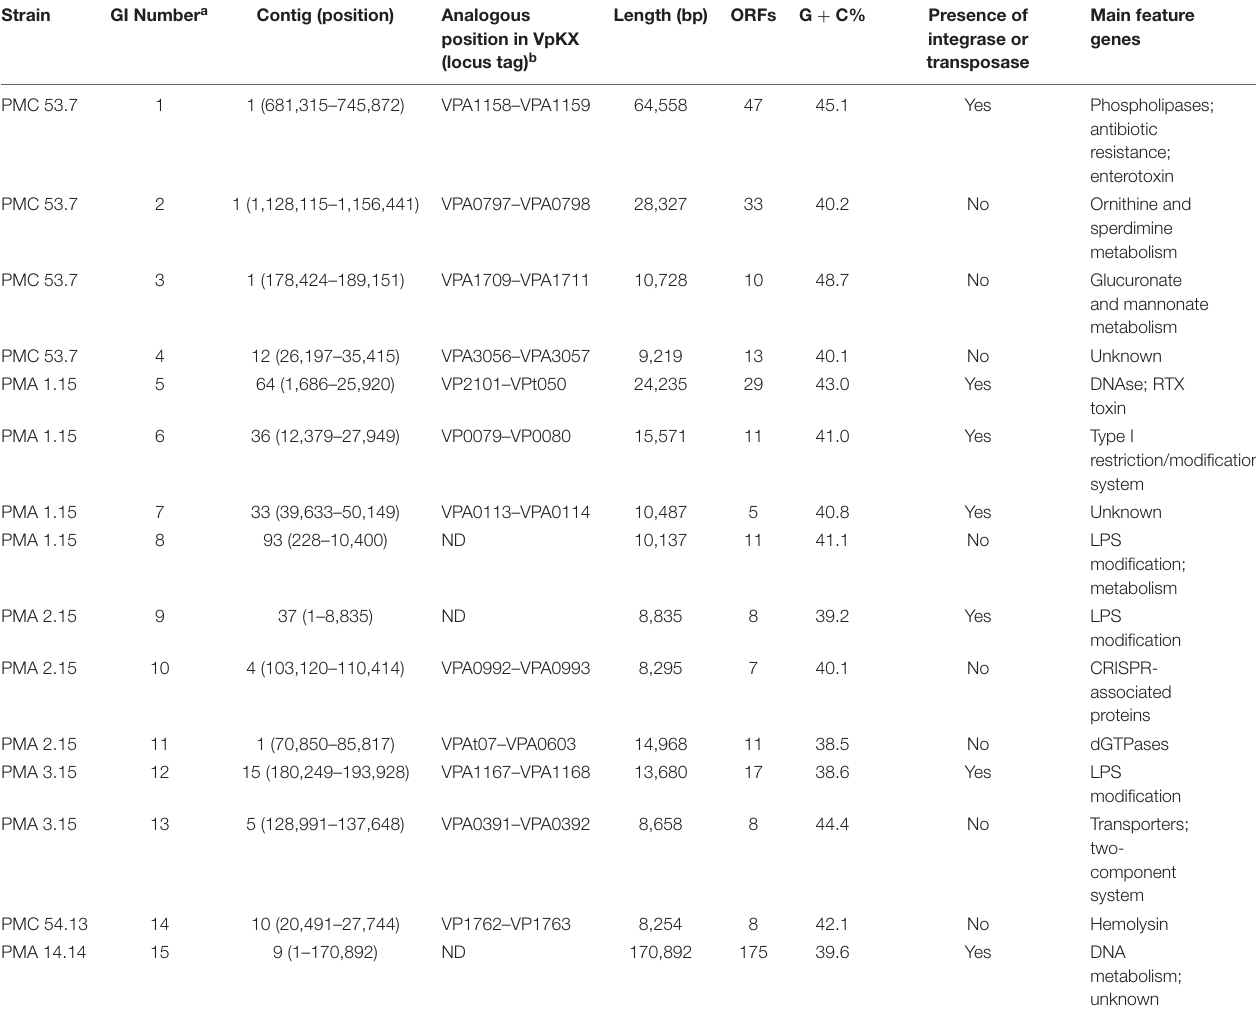
TABLE 4 | Features of the 15 strain-specific genomic islands in the V. parahaemolyticus genomes. Strain GI Number